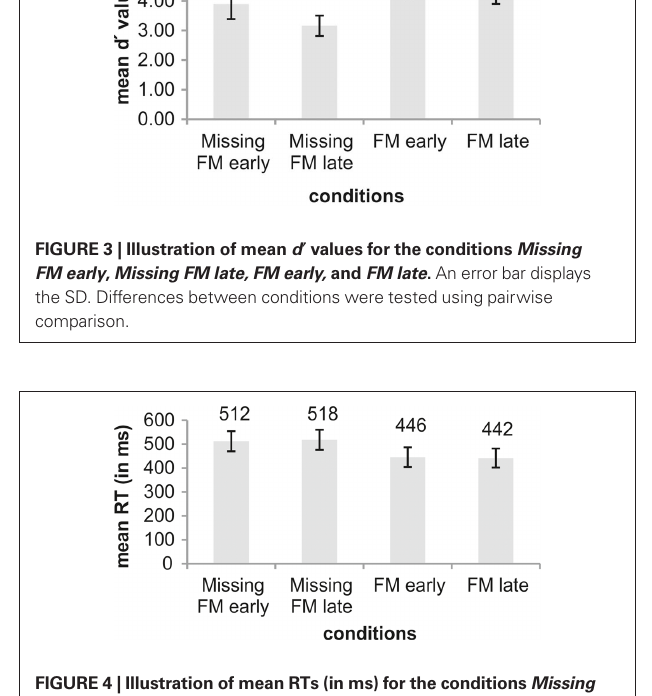
Figure 2 | Topographical distribution of absolute MMN voltages for the FM early condition in the time window from 238 to 278 ms relative to sound onset.